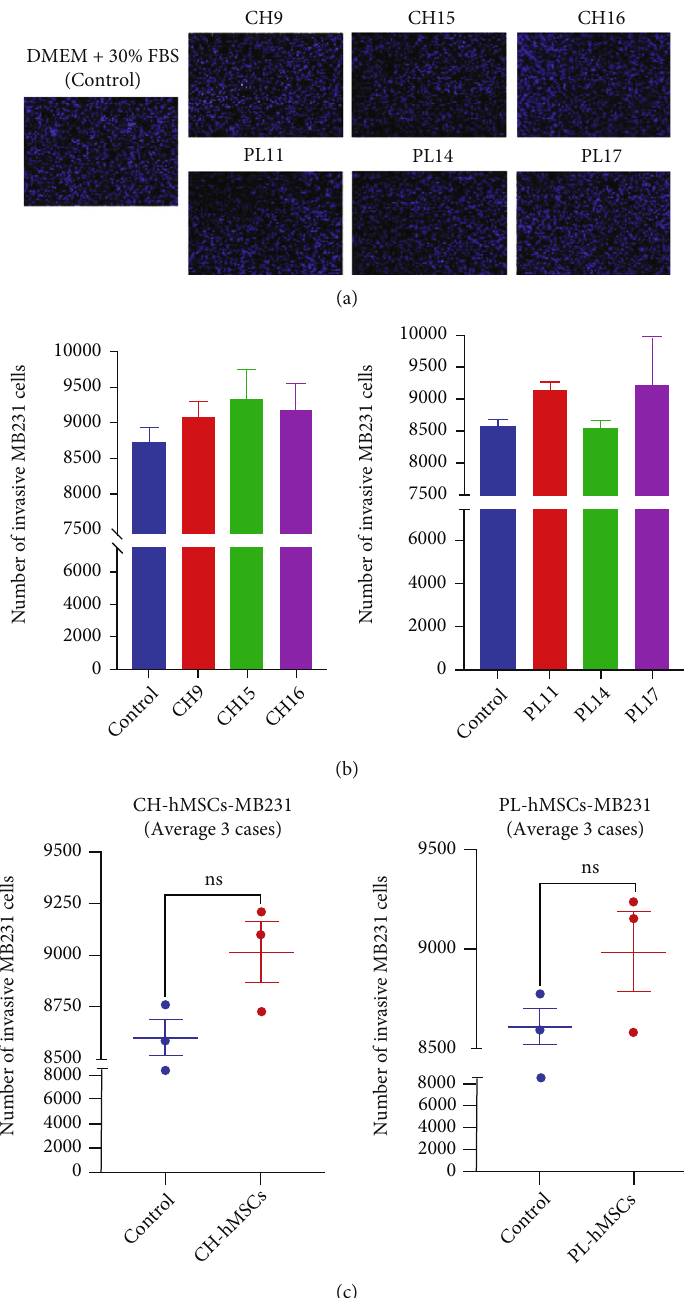
Figure 6: The e ff ect of soluble factors derived from CH-hMSCs and PL-hMSCs on the invasion of human breast cancer MDA-MB231 cells. (a) Representative micrographs of the invasive MDA-MB231 cells after coculture with CH-hMSCs and PL-hMSCs as determined by transwell invasion assay. CH-hMSCs were derived from three donors (CH9, CH15, and CH16), and PL-hMSCs were derived from three donors (PL11, PL14, and PL17). MDA-MB231 cells induced by DMEM medium +30% FBS served as controls. (b) Graphs show the number of invasive MDA-MB231 cells after being cocultured with CH-hMSCs and PL-hMSCs as determined by transwell invasion assay. Data are presented as mean ± SEM of three experiments. CH-hMSCs were derived from three donors (CH9, CH15, and CH16), and PL-hMSCs were derived from three donors (PL11, PL14, and PL17). MDA-MB231 cells induced by DMEM medium +30% FBS served as controls. (c) Graphs show the number of invasive MDA-MB231 cells after being induced by cocultured with CH-hMSCs (average from CH9, CH15, and CH16) and PL-hMSCs (average from PL11, PL14, and PL17). Data are presented as mean ± SEM of three hMSCs. MDA-MB231 cells cultured in DMEM medium +30% FBS served as a